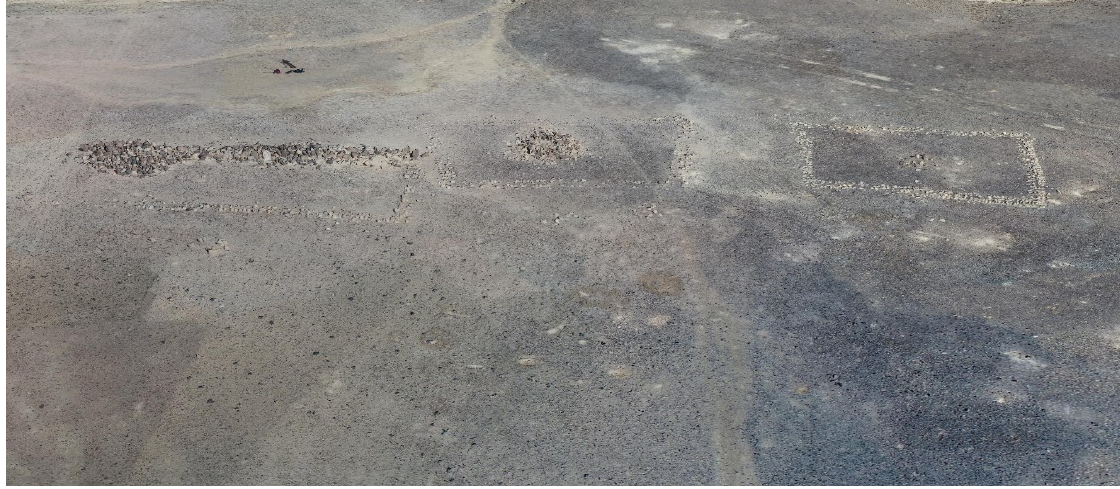
Figure 7 Three open-air shrines at Tzuriaz (Drone photo by E.